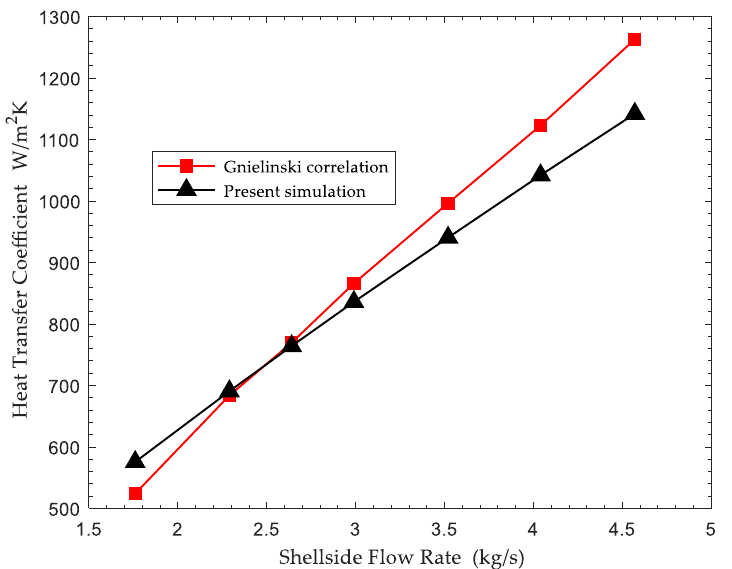
Figure 4. Average heat transfer coefficient comparison between Gnielinski correlation and CFD shell-side flow model.